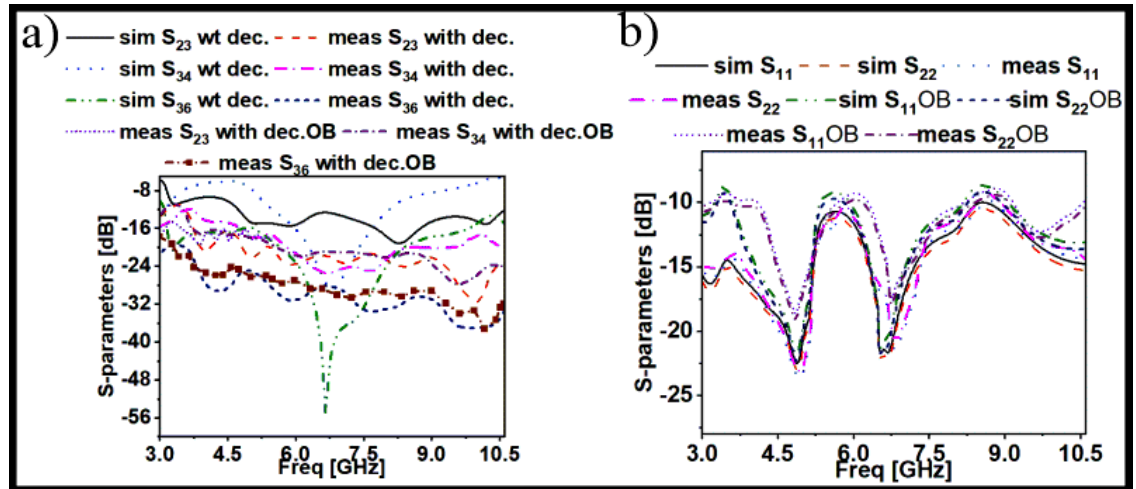
Figure 5. Simulated vs. measured S-parameters: ( a ) isolation; ( b ) return losses.